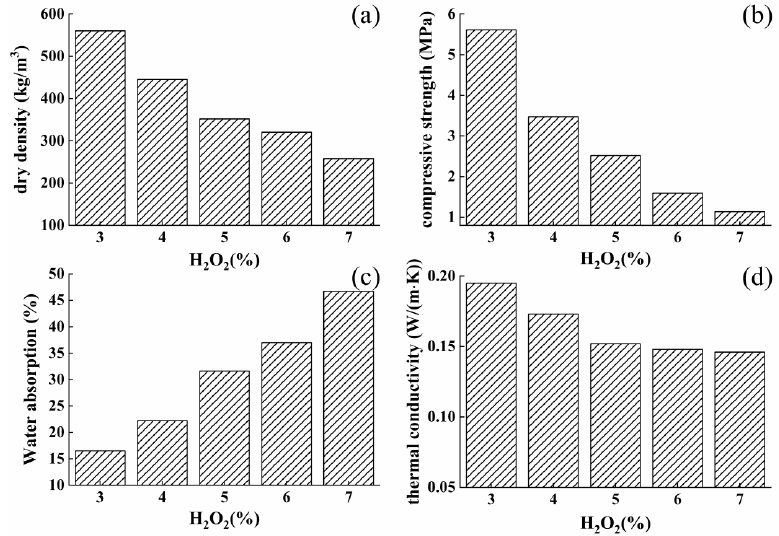
Figure 5. Effect of H 2 O 2 content on properties of foamed concrete: (a) dry density; (b) compressive strength; (c) water absorption; (d) thermal conductivity. strength; ( c ) water absorption; ( d ) thermal